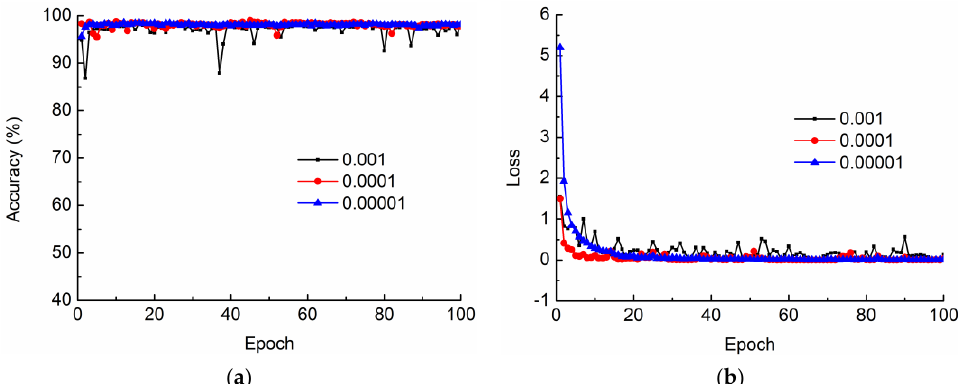
Figure 4. Validation results of different learning rates using AdamW : ( a ) Accuracy; ( b ) loss value.